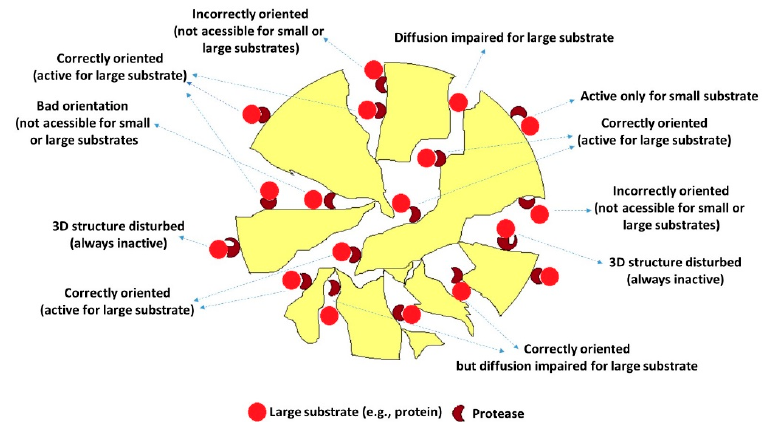
Figure 1. Schematic representation of an enzyme (e.g., a protease) immobilized on porous support to